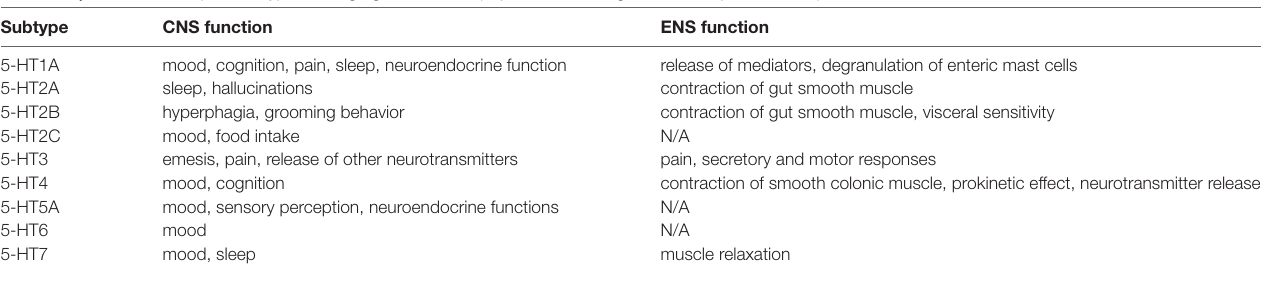
TABLE 1 | Serotonin receptor subtypes through gut-brain axis (adjusted according to O’Mahony et al.,